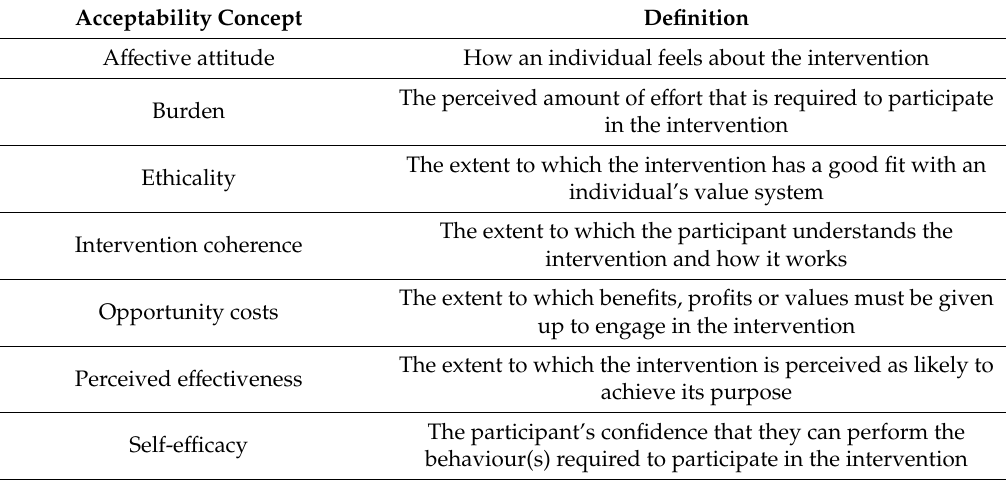
Table 1. The Theoretical Framework of Acceptability constructs and their definitions